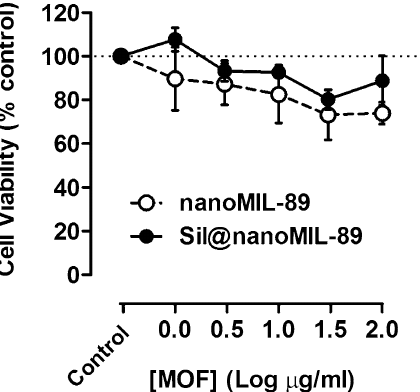
Figure 3. Effect of nanoMIL-89 and Sil@nanoMIL-89 on cell viability in human blood outgrowth endothelial cells. Data are shown as mean ± SEM for n = 8 determinations using cells from 4 separate isolations. Effect on viability was calculated at % control. Statistical analysis for effects between nanoMIL-89 and Sil@nanoMIL-89 was determined by two-way ANOVA followed by Bonferroni Multiple Comparison test where statistical significance was assumed where ( # P < 0.05) and for each one compared to the relevant controls by one-way ANOVA followed by Dunnett’s Multiple Comparison Tests where statistical significance was assumed where (*P < 0.05). Analysis was performed on non-normalised data shown in Supplementary Fig. 3.